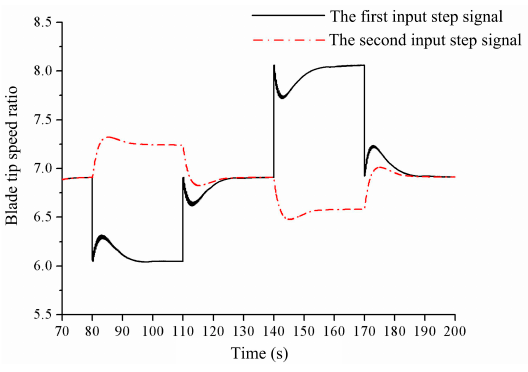
Figure 14. The blade tip speed ratio curve.